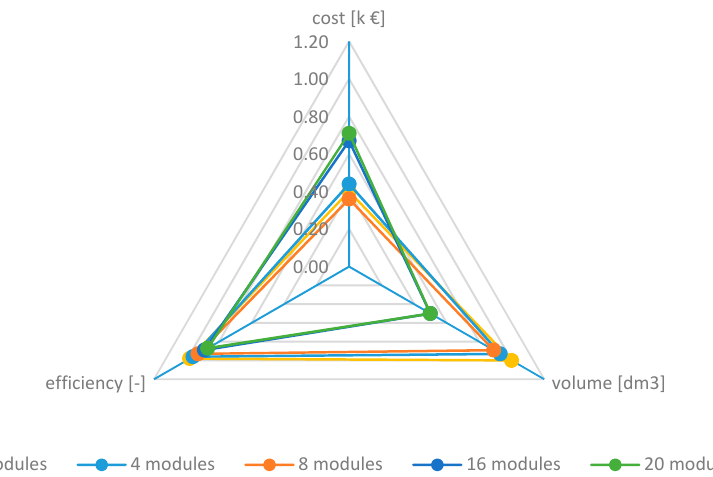
Figure 9. Comparison of qualitative parameters for the modular concept for 500 kHz of switching frequency.